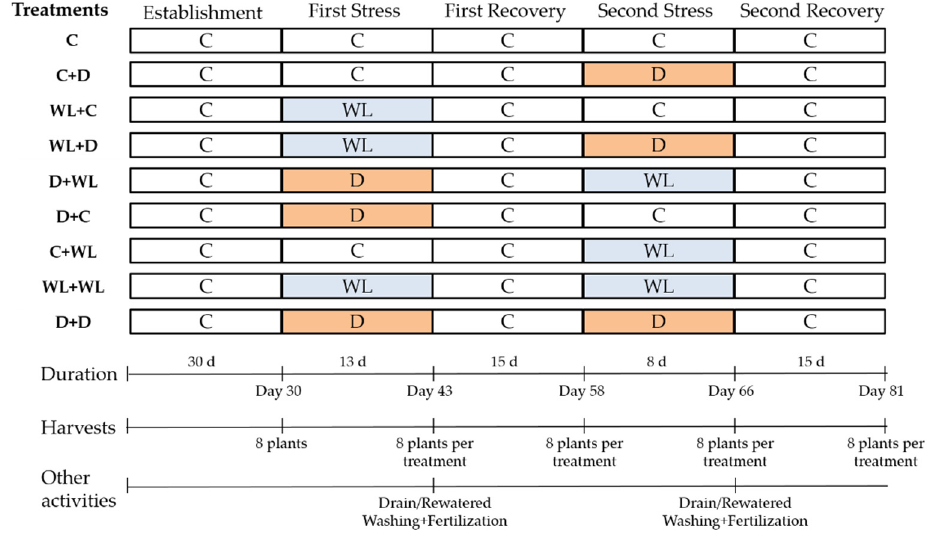
Figure 5. Scheme of the imposition of nine sequential stress treatments, duration of each phase (i.e., establishment, stress, and recovery), moment of harvest, and other activities performed during the